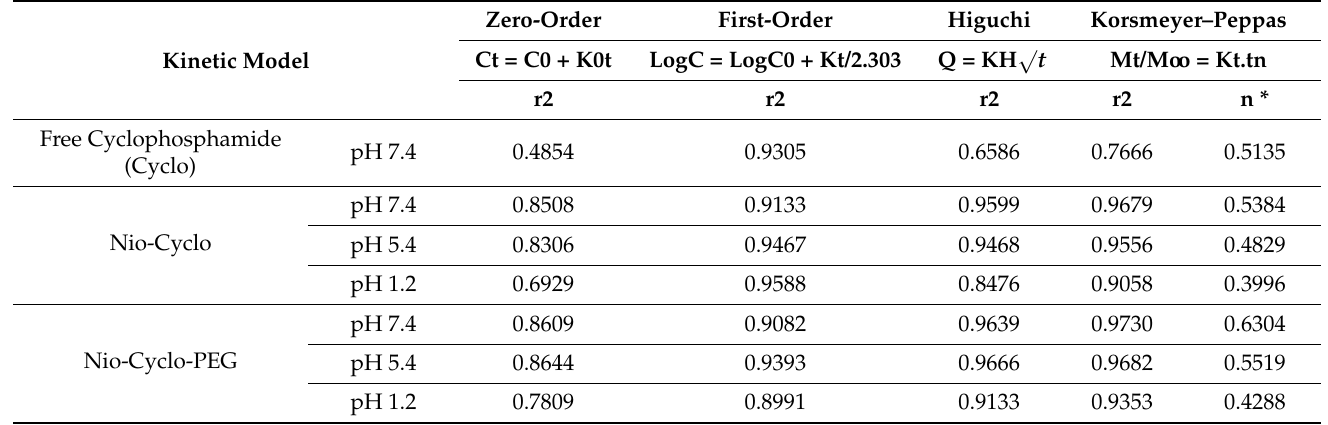
Table 6. The kinetic release models and their parameters for different niosomal